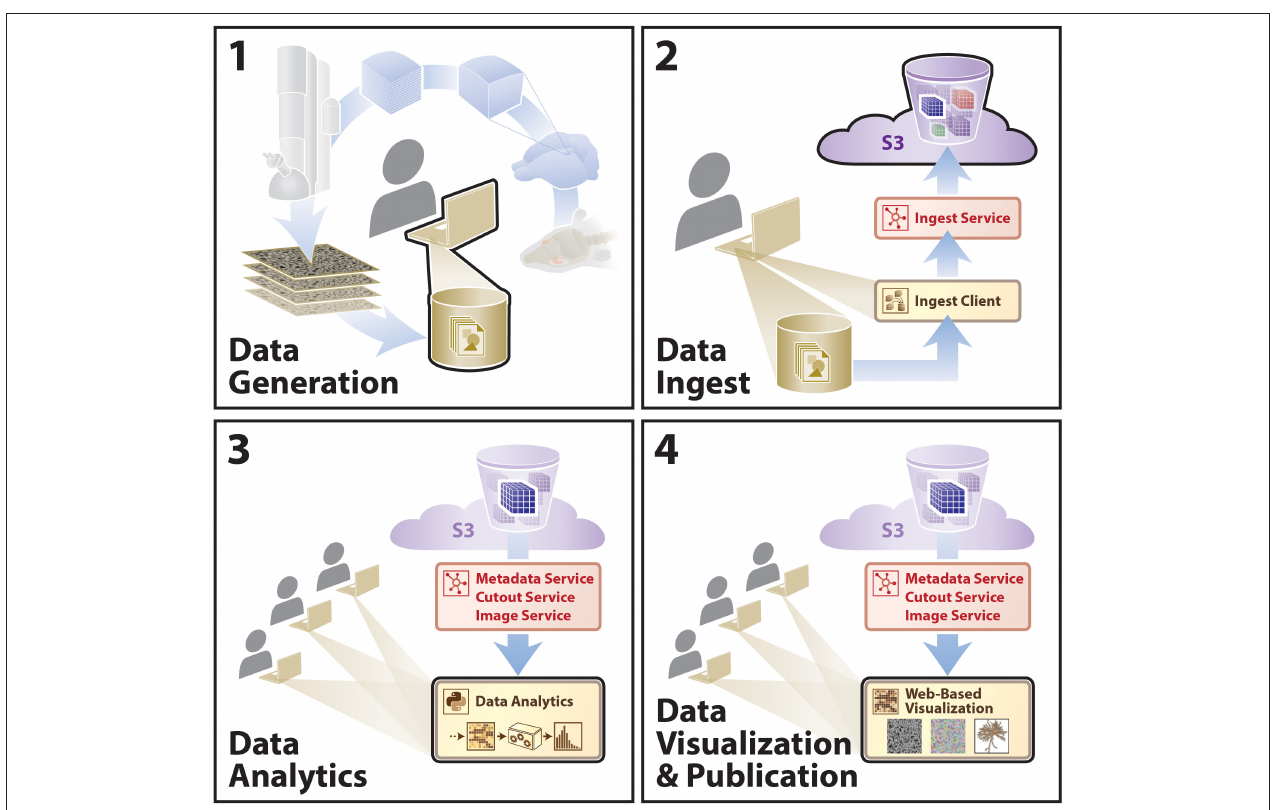
FIGURE 6 | A diagram outlining an example user story showing utilization of the BossDB infrastructure. A typical research group collecting data for a hypothesis will move sequentially from (1)–(4). Other groups will extend these analyses using steps (3) and (4). Sample data included for demonstration (see text footnote 4).